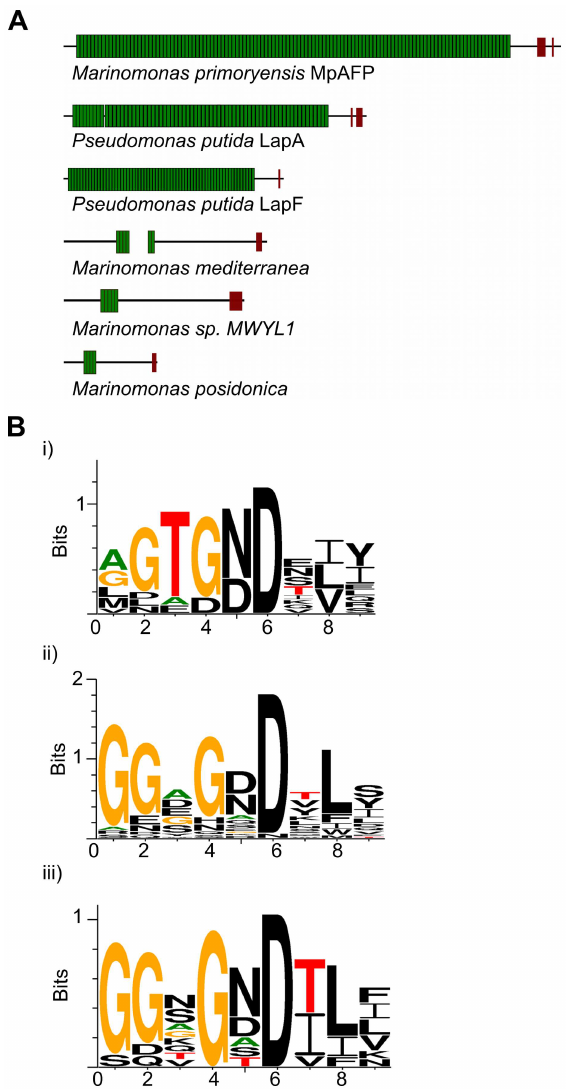
Figure 5. Schematic representations of Mp AFP and other large adhesion proteins. (A) Proteins are drawn to scale. Each Ig-like unit of the large repetitive region is shown as a green rectangle. The RTX- repeats in the C-terminal region are illustrated as brown blocks. The schematic diagrams are based on the following sequences from NCBI: Pseudomonas putida KT2440 LapA (NP_742337) and LapF (NP_742967), M. sp. MWYL1 hemolysin-type calcium-binding protein (YP_001340713), M. posidonica outer membrane adhesin-like protein (YP_004481992) and the M. mediterranea homologues (YP_004313542 + YP_004313541) that are separated by one nucleotide preceding an irregular GTG start codon. (B) Weblogo representations of 9-aa RTX repeats. Consensus plots are shown for: i) 12 RTX repeats in Mp AFP_RIV; ii) 29 RTX repeats from homologs of Mp AFP from three other Marinomonas species shown in Fig. 5A; iii) 10 RTX repeats in adhesion proteins LapA and LapF. As shown in the weblogo plots, the RTX repeats from the three homologs of Mp AFP and the LAPs follow the consensus of the conventional nine-residue RTX repeats of GGxGxDxUx (Fig. 5Bii and 5Biii). The RTX-like repeats in Mp AFP_RIV deviate from the conventional RTX repeats by introducing conserved ice-binding residues at positions 3 and 5 (Thr and Asx, Fig. 5Bi). Residues are colored black except for Gly (orange), Thr (red), and Ala (green).